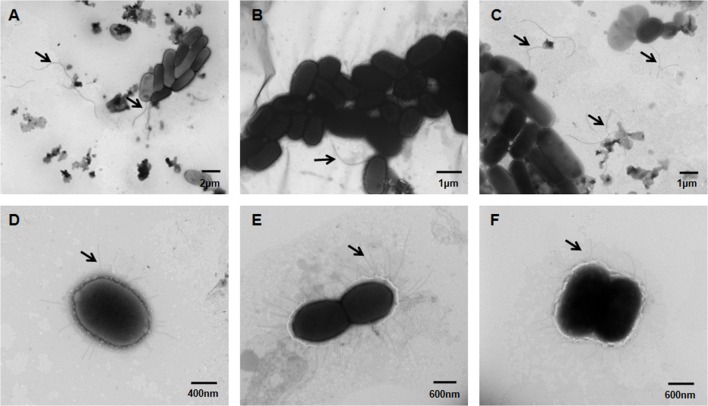
Transmission electron micrographs of APEC strains. Bacteria were grown overnight on LB agar, and then harvested, fixed, and negatively stained with 2% phosphotungstic acid. Numerous long flagella were observed on the surfaces of the wild-type strain APCE94 (A) and the complementation strain APCE94CΔeivC (C). Few flagella were observed on the mutant strain APCE94ΔeivC (B). Augmented fimbriae surrounding the bacteria were observed on the mutant strain APCE94ΔeivC (E), compared with those of the wild-type strain APCE94 (D) and the complementation strain APCE94CΔeivC (F).